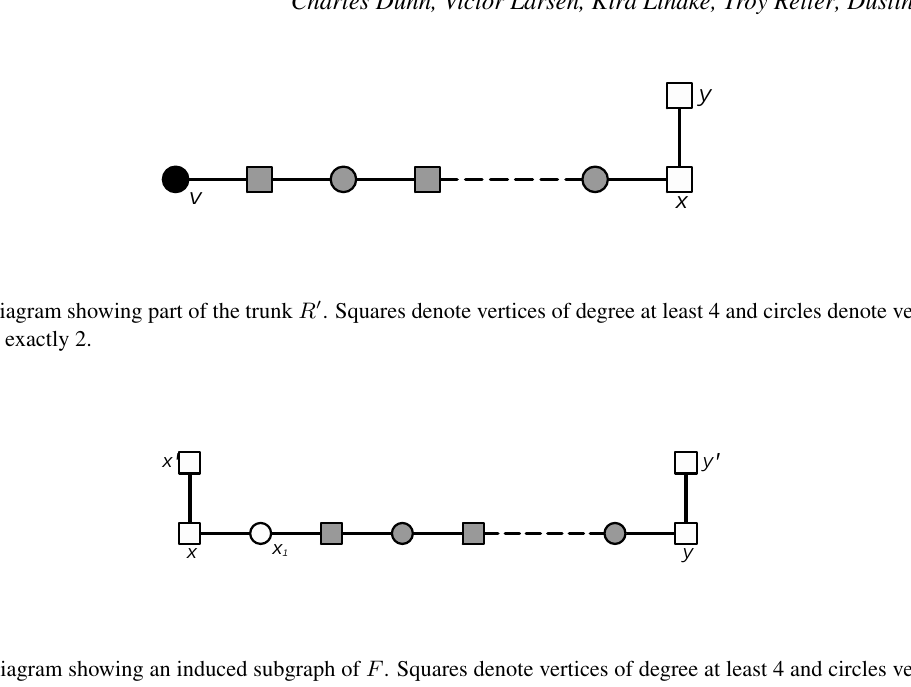
Fig. 8: Diagram showing an induced subgraph of F . Squares denote vertices of degree at least 4 and circles vertices of degree exactly